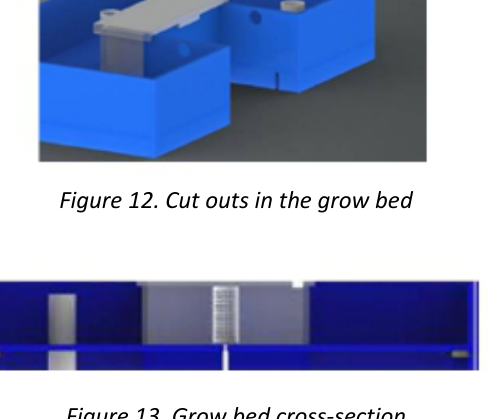
Figure 13. Grow bed cross-section